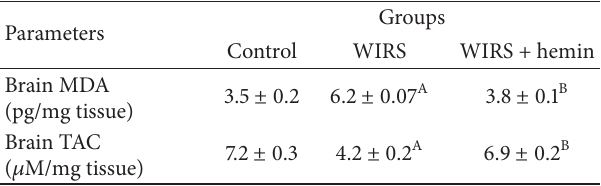
Table 2: Effect of 6-hour water immersion restraint stress (WIRS) with or without hemin on brain oxidative state in male albino rats.